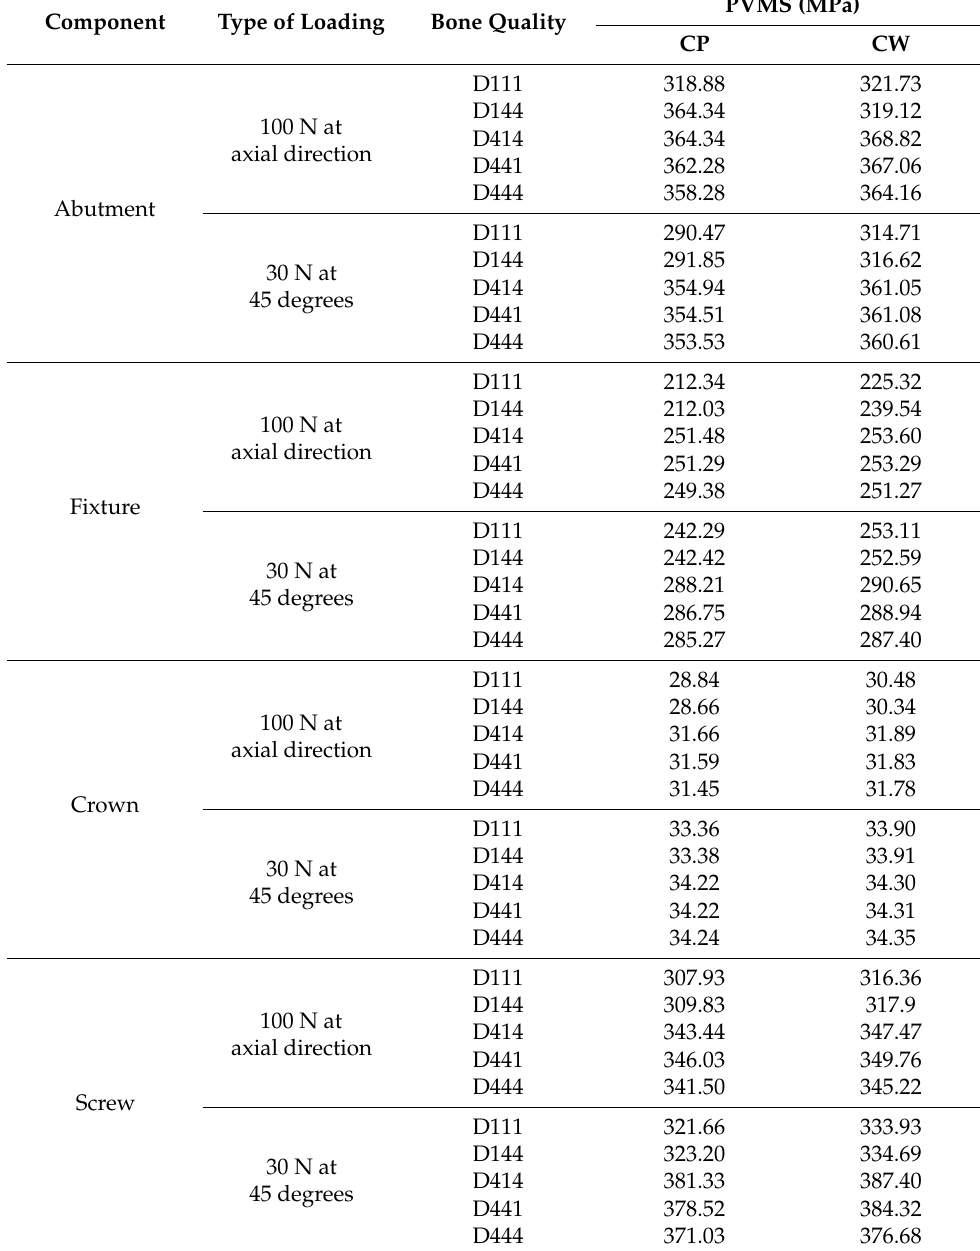
Table 5. The PVMS of CP and CW in five bone-quality